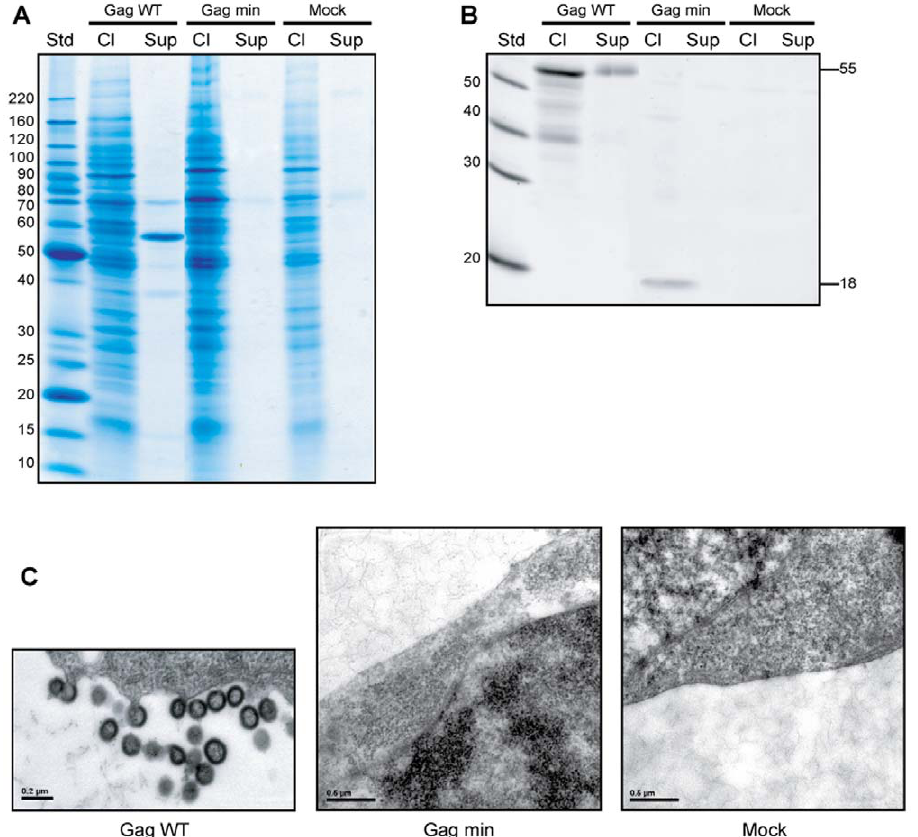
Figure 2. Gag min in the context of an expression vector fails to produce VLPs. (A) 293T cells were transfected with vectors expressing either Gag WT or Gag min. The mock represents 293T cells transfected with the empty pcDNA3.1 ( + ) vector (used as a negative control). At 48 h post- transfection, cell lysates (Cl) and cell-free supernatants (Sup) were analyzed on a gradient SDS-PAGE and the protein stained with Coomassie Brilliant Blue. (B) In parallel, an IP assay was performed using an anti-p24 antibody on the same samples (Cl and Sup). Precipitated proteins were run on a gradient SDS-PAGE and Gag proteins were analyzed by western blotting (WB) with a biotinylated anti-p24 antibody. (C) 293T cells expressing Gag WT or Gag min construct were analyzed by TEM (magnification: 6 50,000). The Biochemical experiments shown are representative of at least three independent experiments and two for the microphotographs.